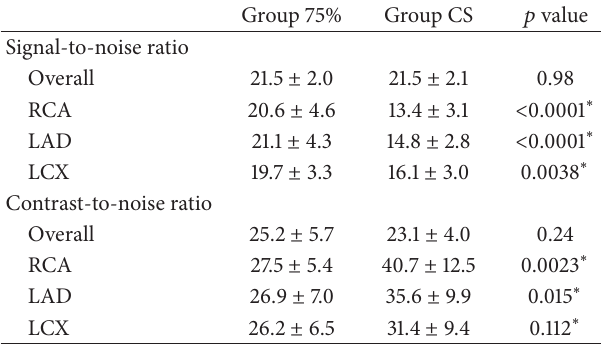
Table 5: Objective image